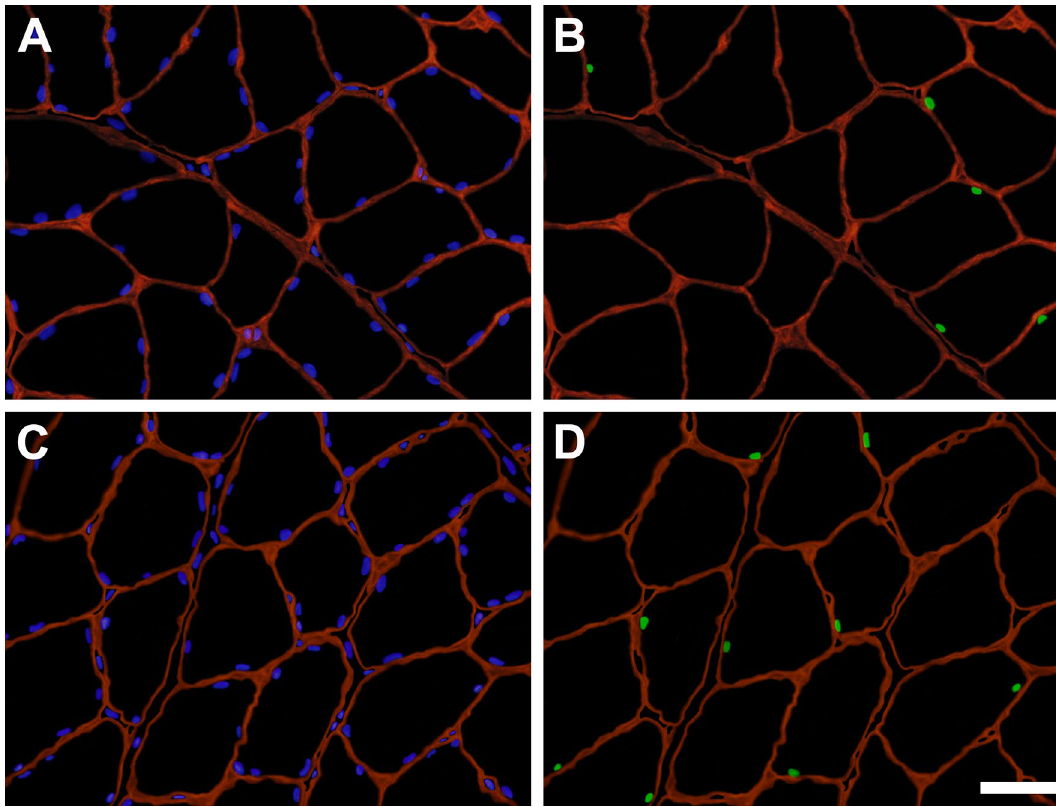
Figure 2. Immunofluorescent identification of satellite cell nuclei (SCN) in cross sections of anterior latissimus dorsi muscles obtained from control and mesterolone-treated chickens. ( A ) and ( B ) represent a section obtained from a control bird. ( C ) and ( D ) represent a section obtained from a mesterolone-treated bird. ( A ) and ( C ) show all nuclei in blue (DAPI staining) and the basal laminae of muscle fibers in red (anti-laminin staining). ( B ) and ( D ) show SCN in green (anti-Pax7 labeling) and the basal laminae in red. Scale bar = 30